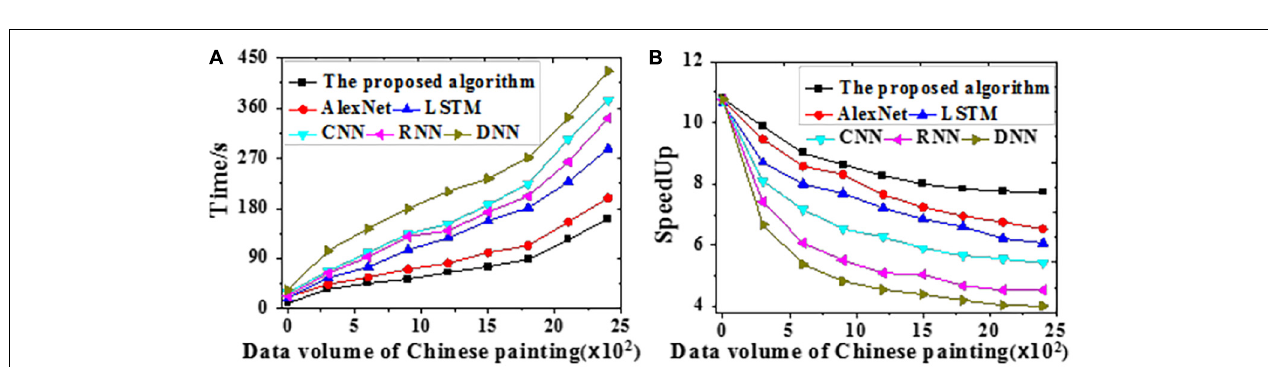
FIGURE 8 | The time delay error of different algorithms for Chinese painting emotion recognition [ (A) The test dataset; (B) The training dataset].